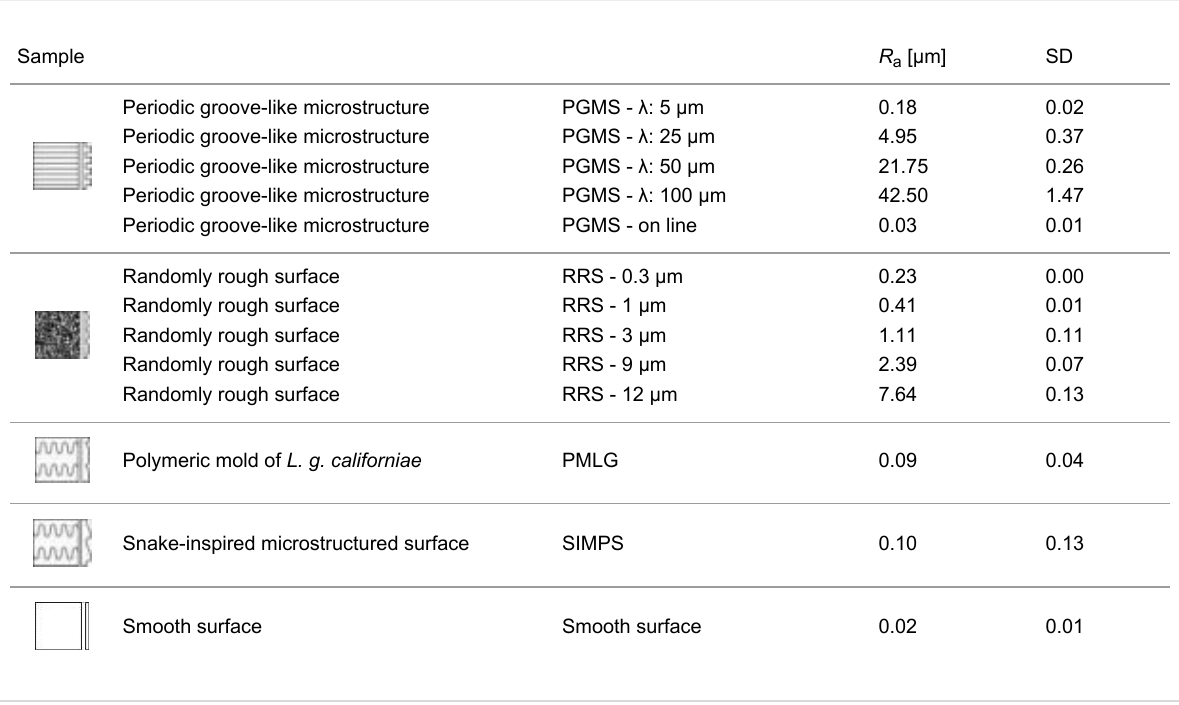
Table 1: Surface roughness (Ra) of all investigated polymer surfaces. "On line" roughness was measured on top of the line, along the microstructure. λ : pitch dimension. SD: standard deviation.